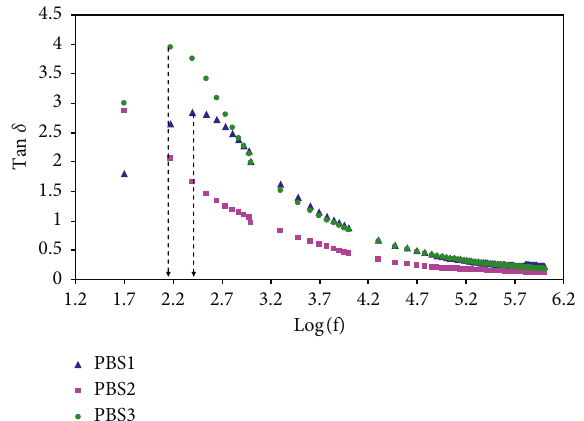
Figure 8: Loss tangent (tan δ ) versus frequency at ambient tem- perature for CS:POZ blend samples.